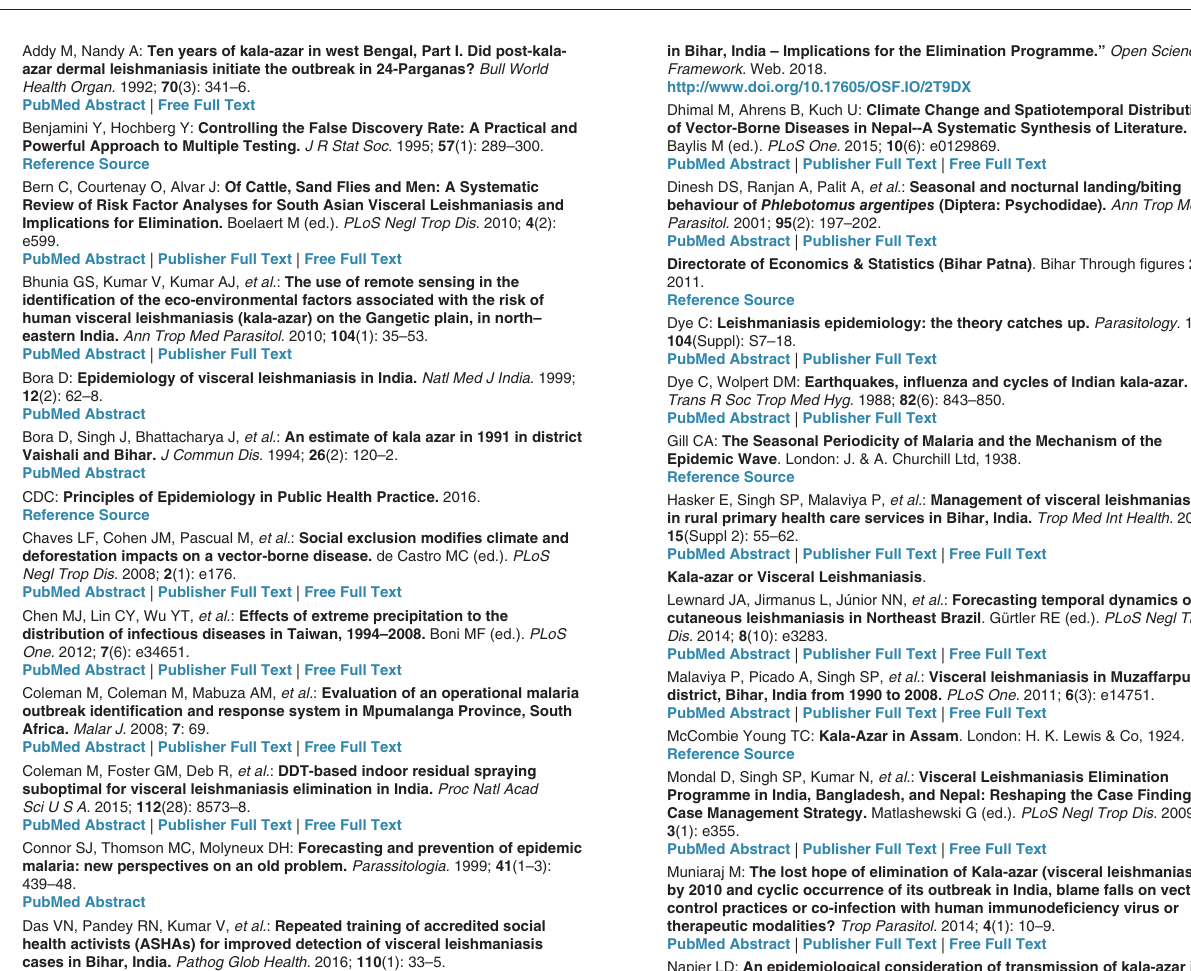
Supplementary Table 1: Data sources accessed